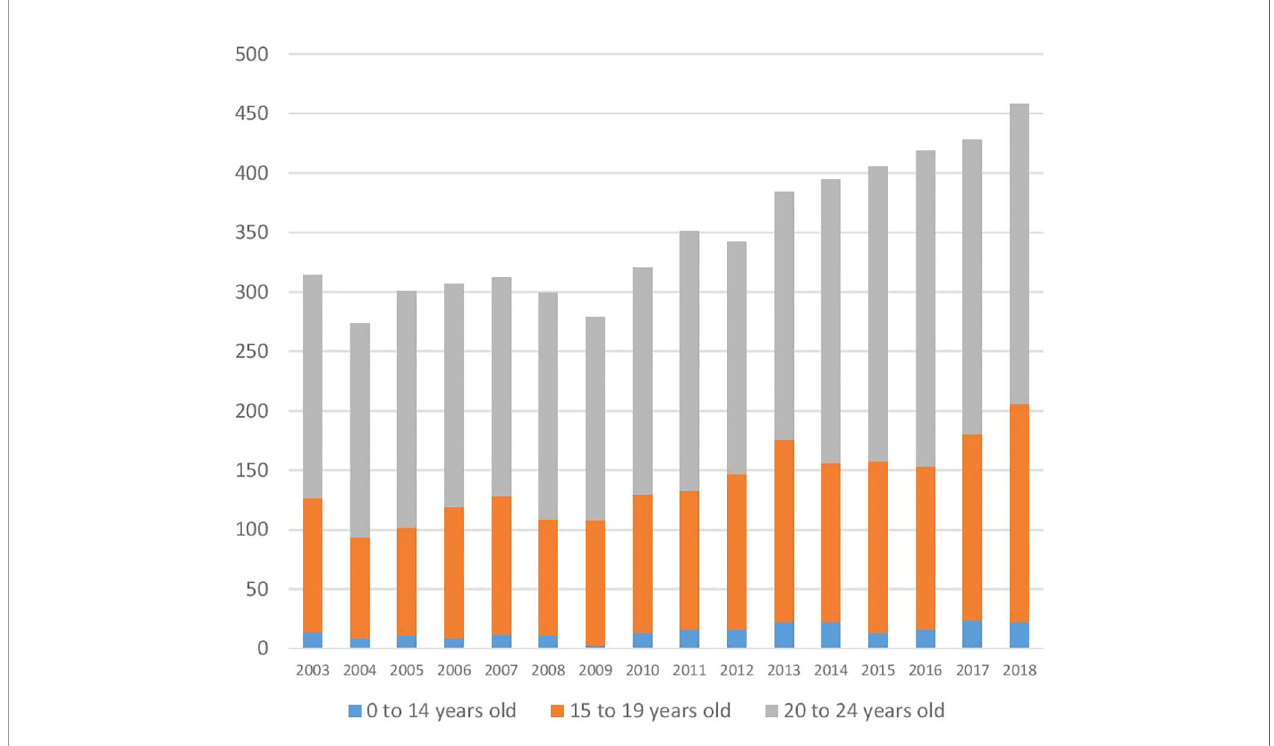
FIGURE 1 | Suicides by young Australians from 2003 to 2018. Source ABS 3303.0 - Causes of Death, Australia,